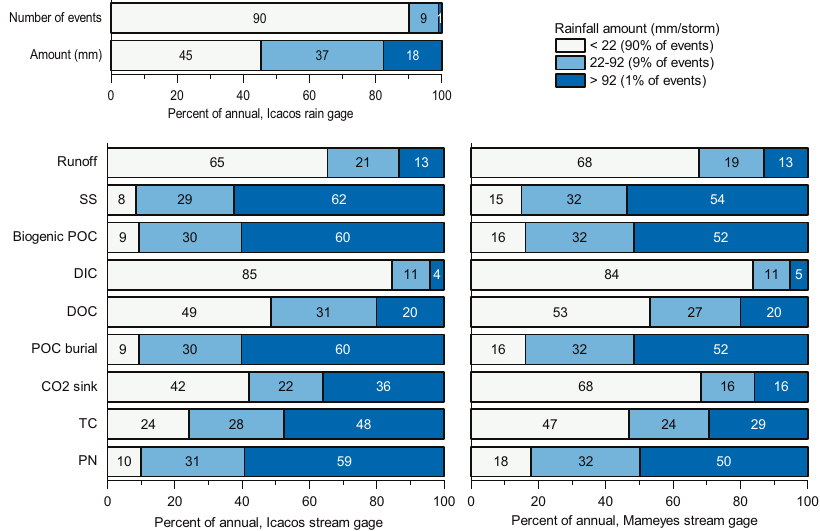
Fig. 3 Percent contribution of annual runoff and river exports by rainfall event size for the Icacos and Mameyes Rivers. These exports are separated by rainfall amount as a percentage of annual total (SS suspended sediment, POC biogenic particulate organic carbon, DIC dissolved inorganic carbon, DOC dissolved organic carbon, POC burial estimated POC burial in ocean if biogenic POC burial ef fi ciency is estimated at 22% 28 , CO2 sink estimated